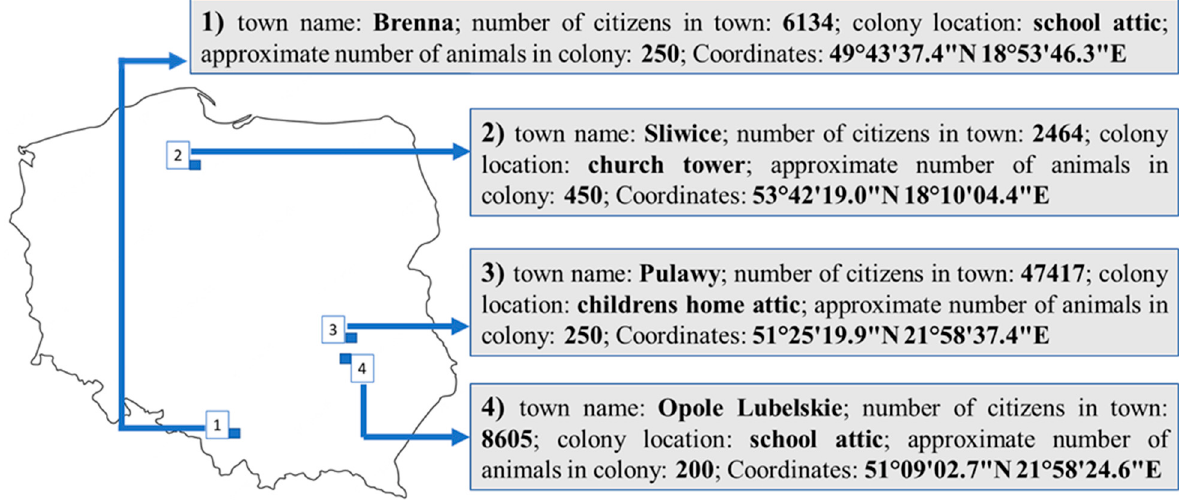
Figure 1. Location and characteristics of bat colonies included into the study.